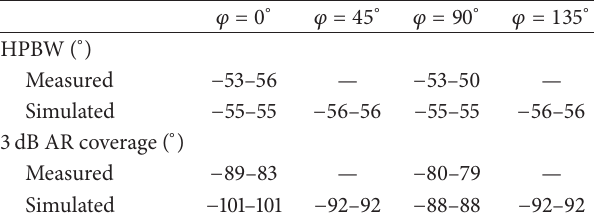
Table 4: Measured and simulated HPBW and 3dB AR coverage at 1.55